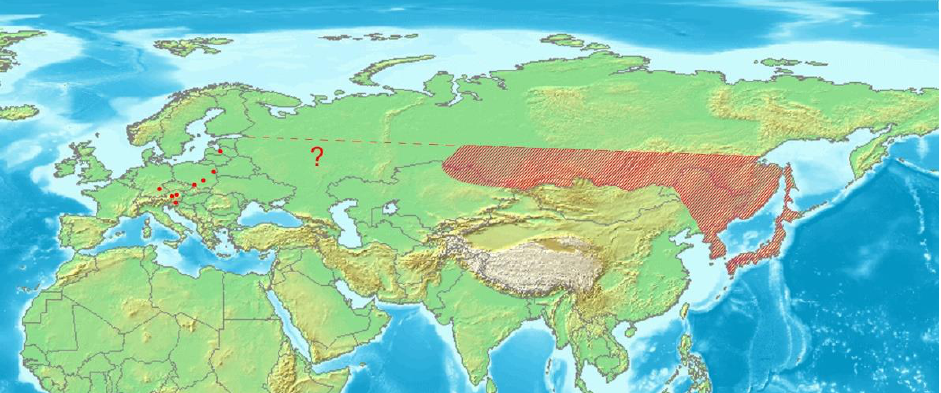
Figure 16. Distribution of Euryommatus mariae in Asia (shaded area) and Europe (dots). Map based on an image obtained from the Demis World Map Server open source (http://web-map.iwmi.org/DataSrc.htm, currently unavailable).